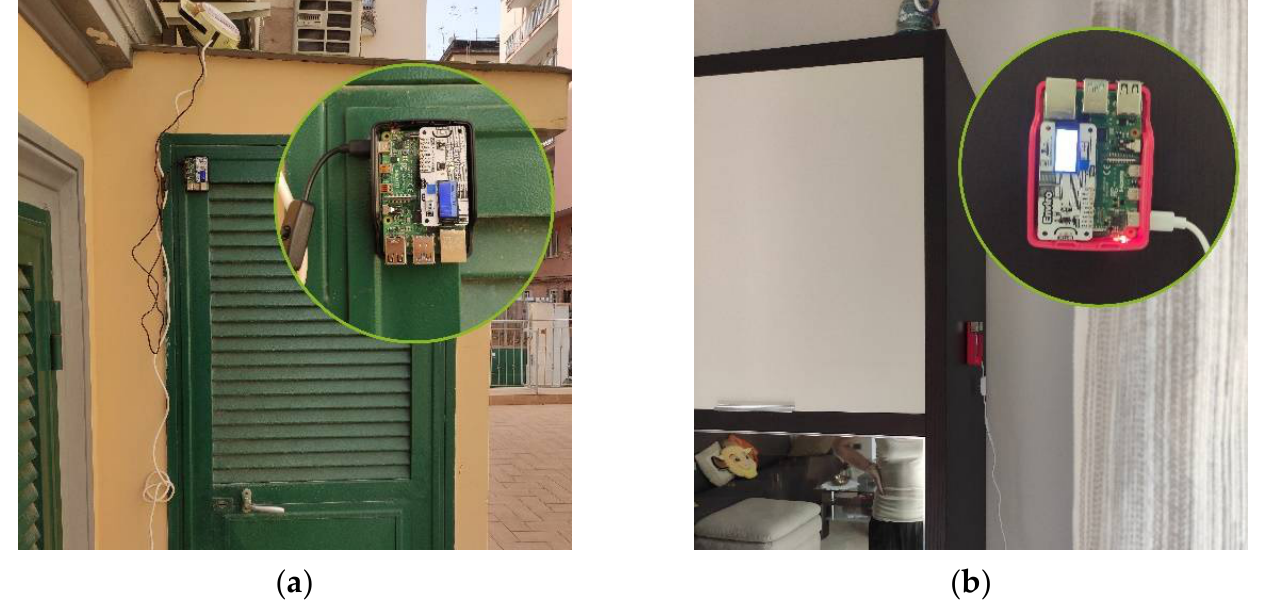
Figure 6. The sensors installed at the Materdei building: ( a ) Outdoor installation; ( b ) Indoor installation.